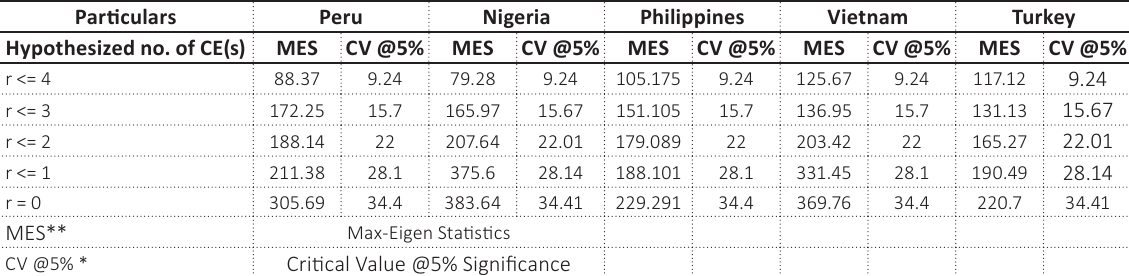
Table 3. Johansen co-integration test results country-wise: maximum eigen value statistics, without linear trend and constant in cointegration